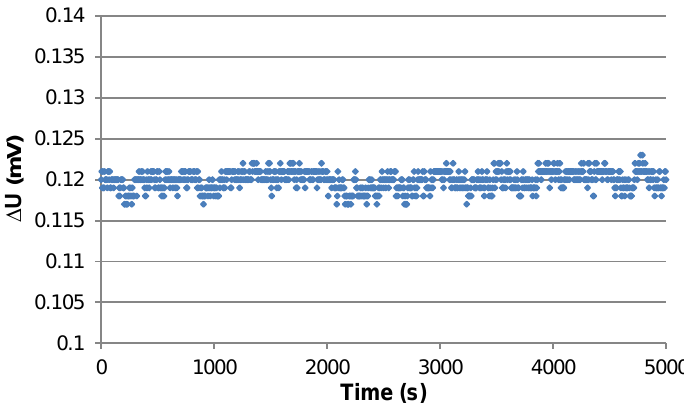
Figure 6. Sensor’s output voltage difference vs. time in the zero flow case.